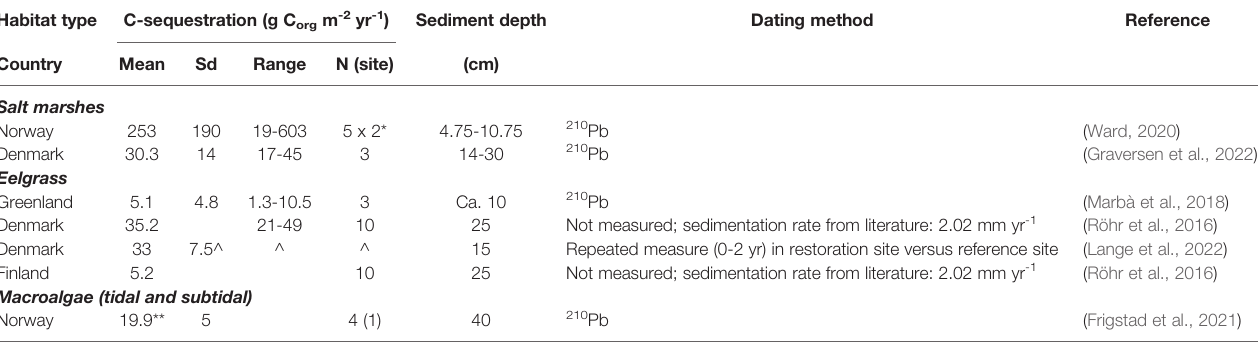
TABLE 3 | Sediment C-sequestration rates for Nordic BC habitats with indication of mean levels, standard deviation (sd), range and number of observations (n).